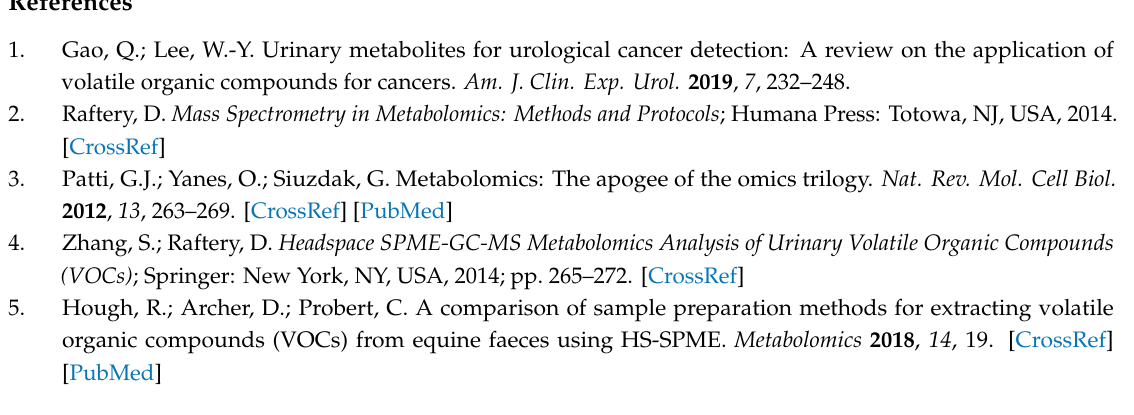
VOCs. Table S4: The full breakdown of classification of VOCs per treatment